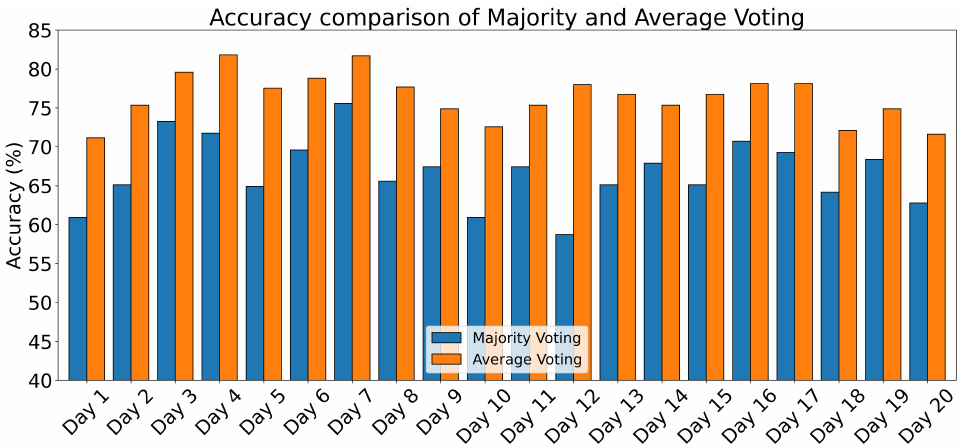
Figure 9. Accuracy in % of for majority voting and average